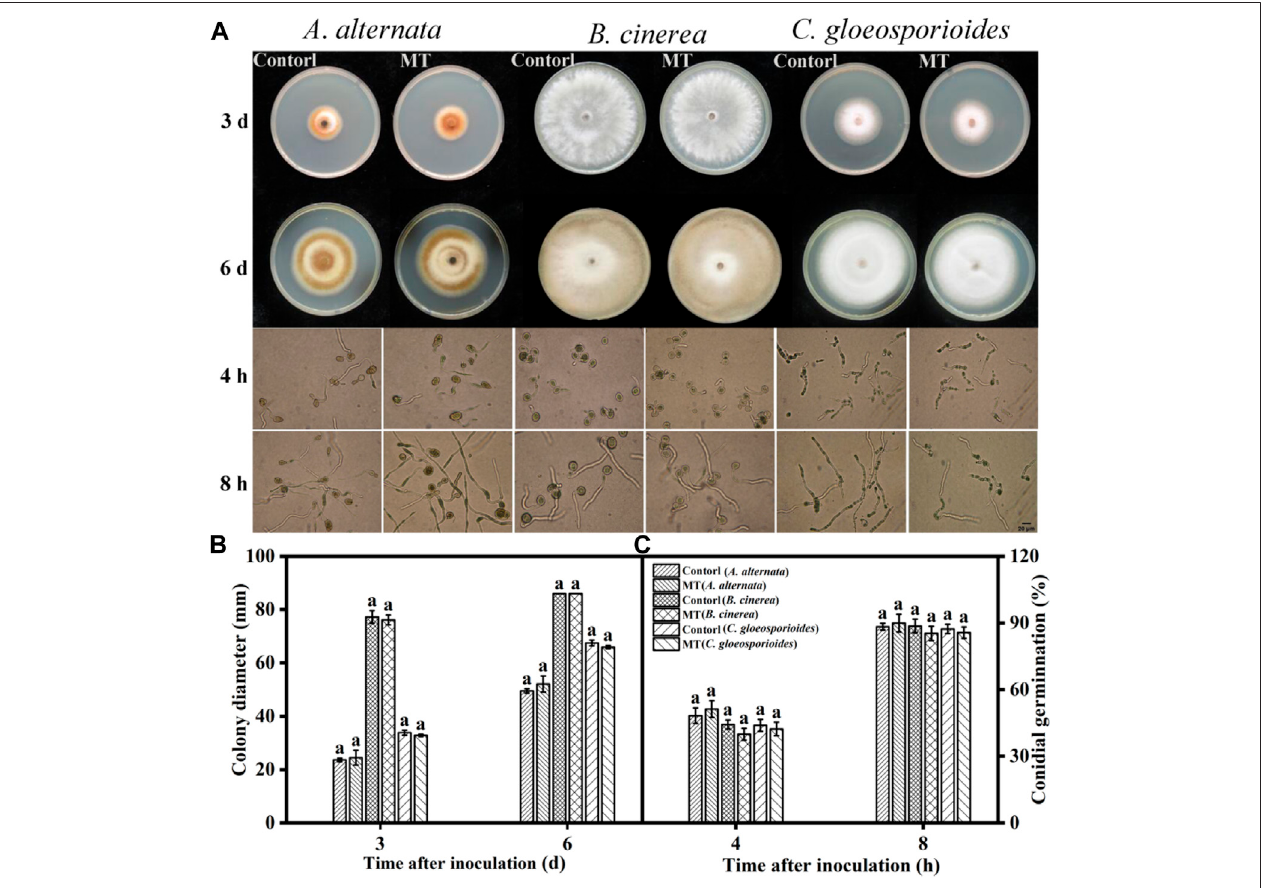
FIGURE 1 | Effects of MT on in vitro growth inhibition and spore germination of A. alternata , B. cinerea , and C. gloeosporoides : (A) Photographs of cultures, (B) colony diameters, and (C) spore germination rates. Signi fi cant differences between the MT-treated and control groups were compared for the same strain. Different letters represent signi fi cant differences ( p < 0.05). Data are presented as the mean ± SD.